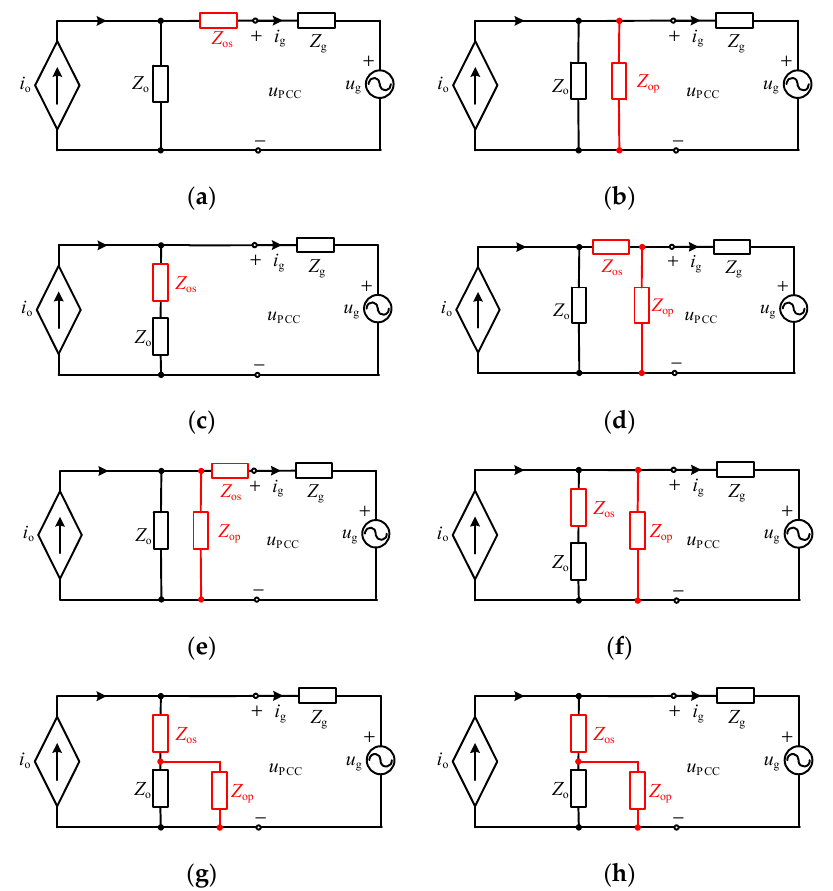
Figure 2. Methods of reshaping output impedance based on equivalent circuit: ( a , c ) series reshaping; ( b ) parallel reshaping; ( d – h ) combination of series and parallel reshaping.